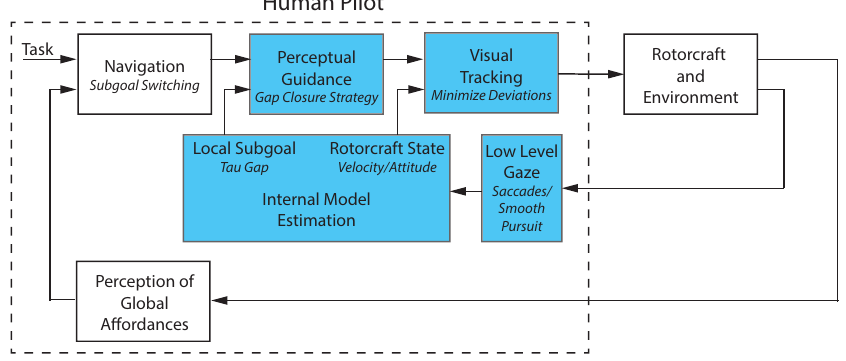
Figure 2. General human–machine system model for human perception and